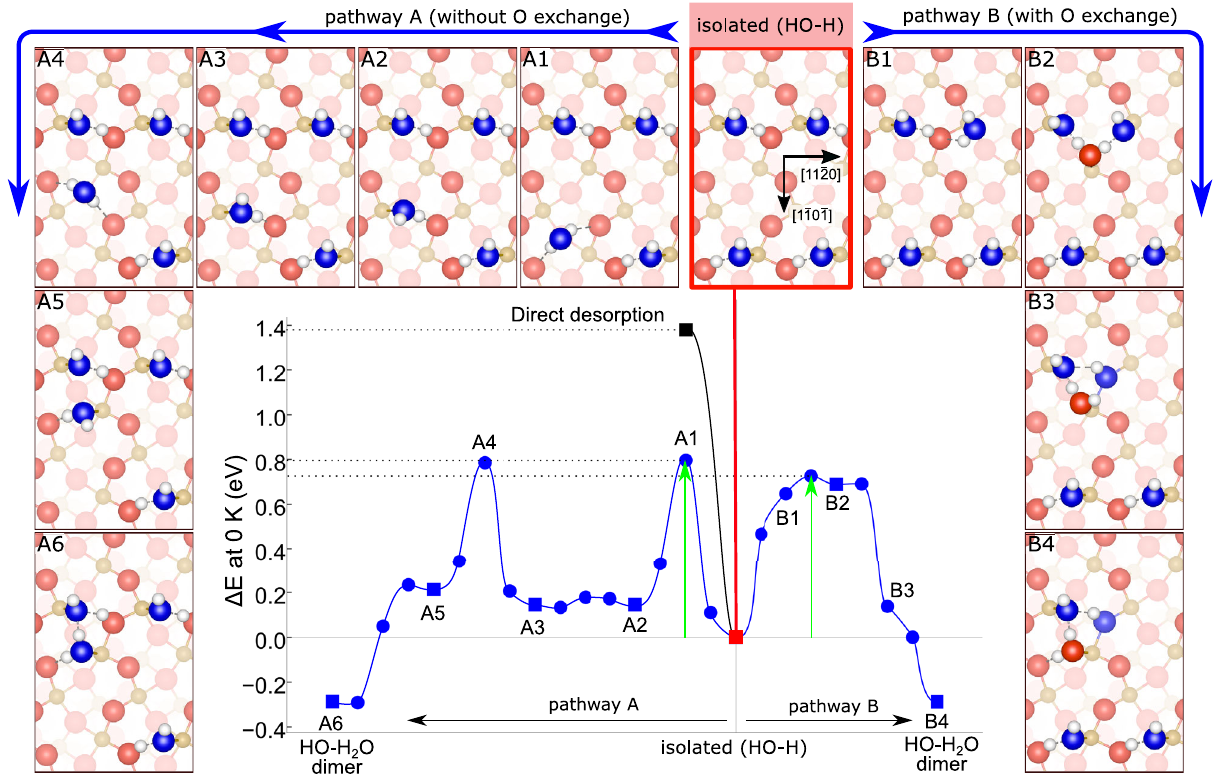
-- 102) surface. Oxygen atoms